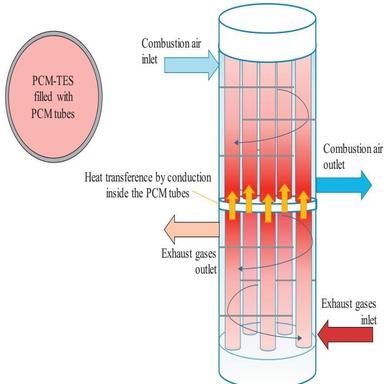
Diagram of a PCM-TES based on a double HX chamber filled with PCM tubes.